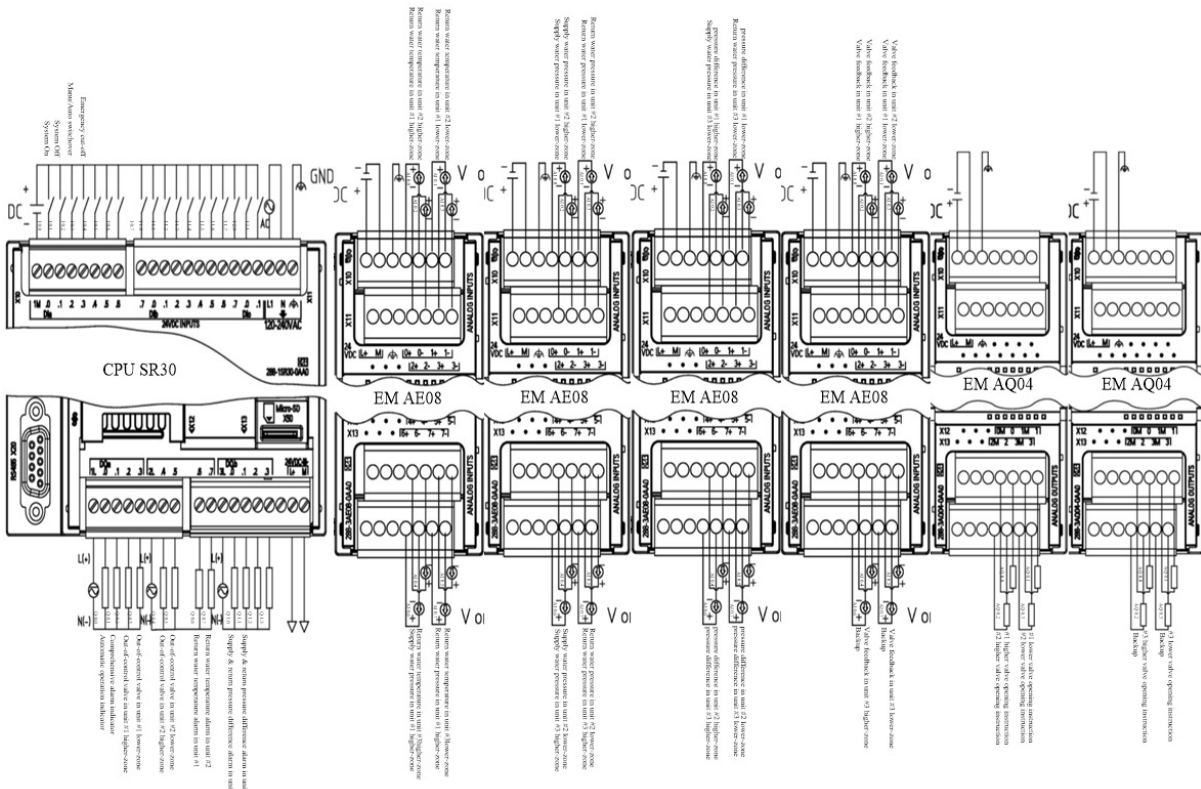
Fig. 5 PLC controller’s hardware configuration